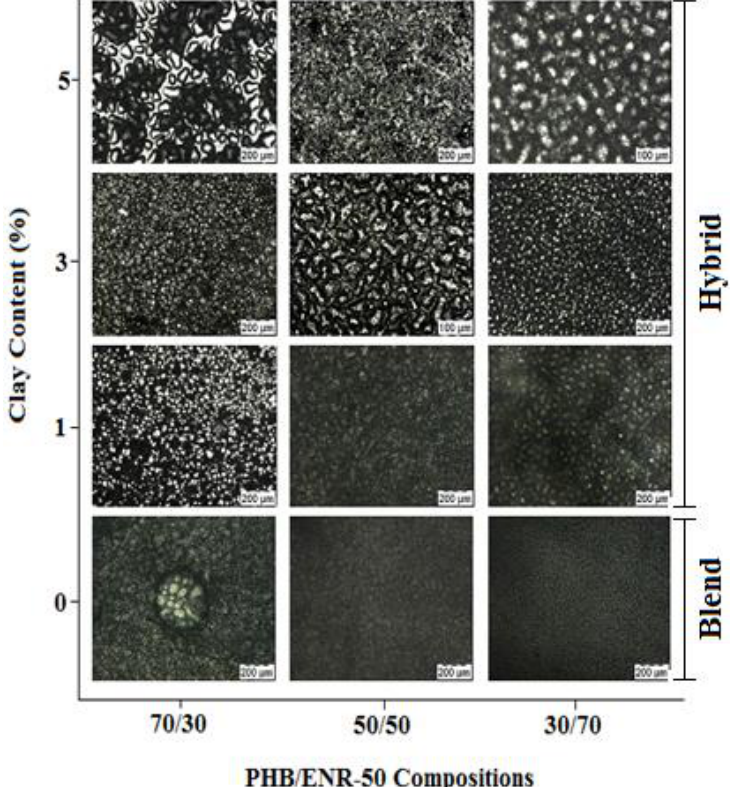
Figure 1. Polarized Optical Micrographs of various PHB/ENR-50 blends and the respective blends containing various wt% MMT at room